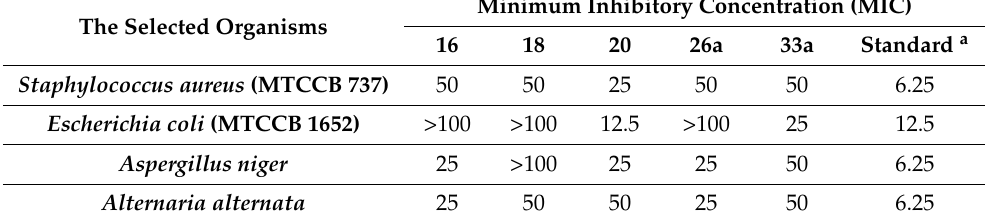
Table 2. Minimum inhibitory concentration (MIC, mg/mL) of the synthesized compounds 16 , 18 , 20 , 26a , and 33a